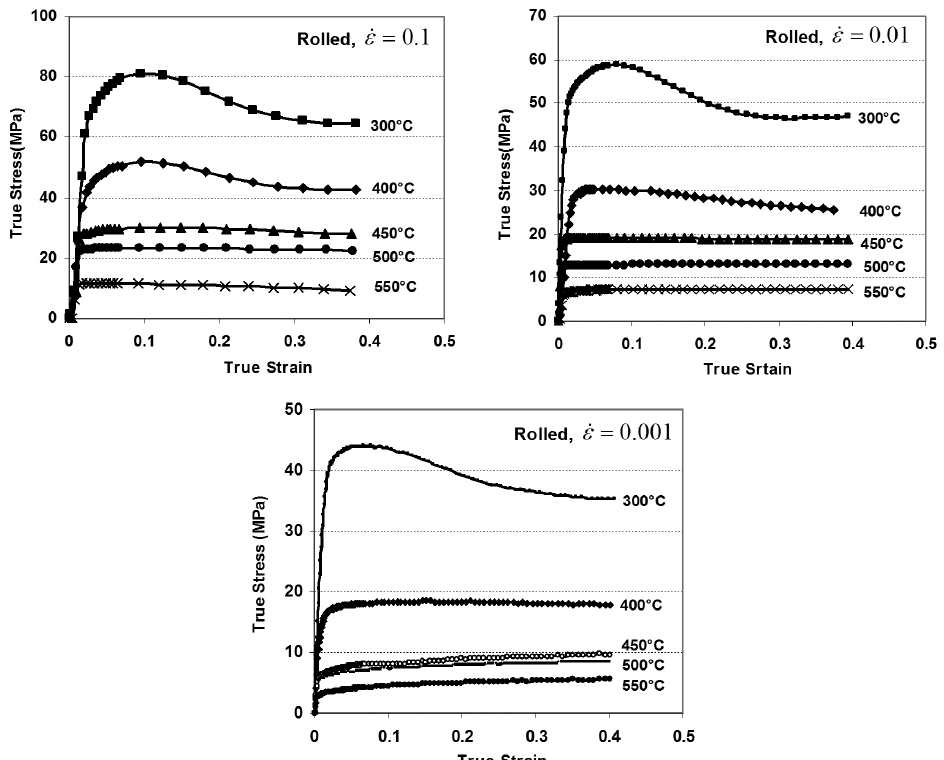
Figure 1. The typical true stress-strain curves of the experimental alloy obtained by hot compression